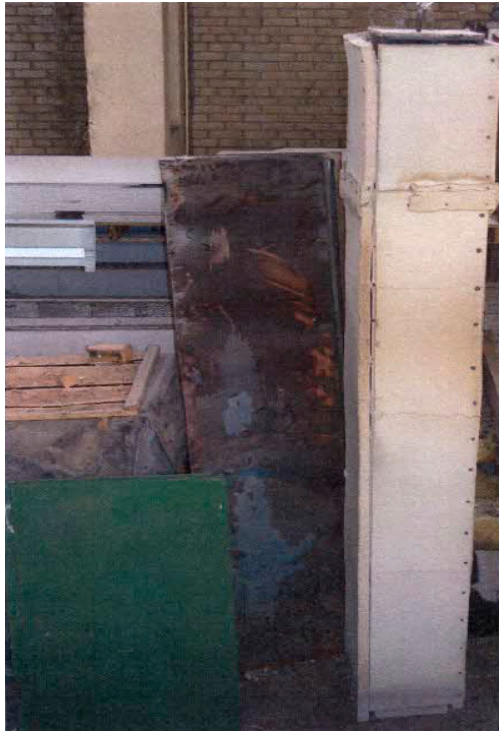
Figure 13. Engineering prototype after the test, standard fire.